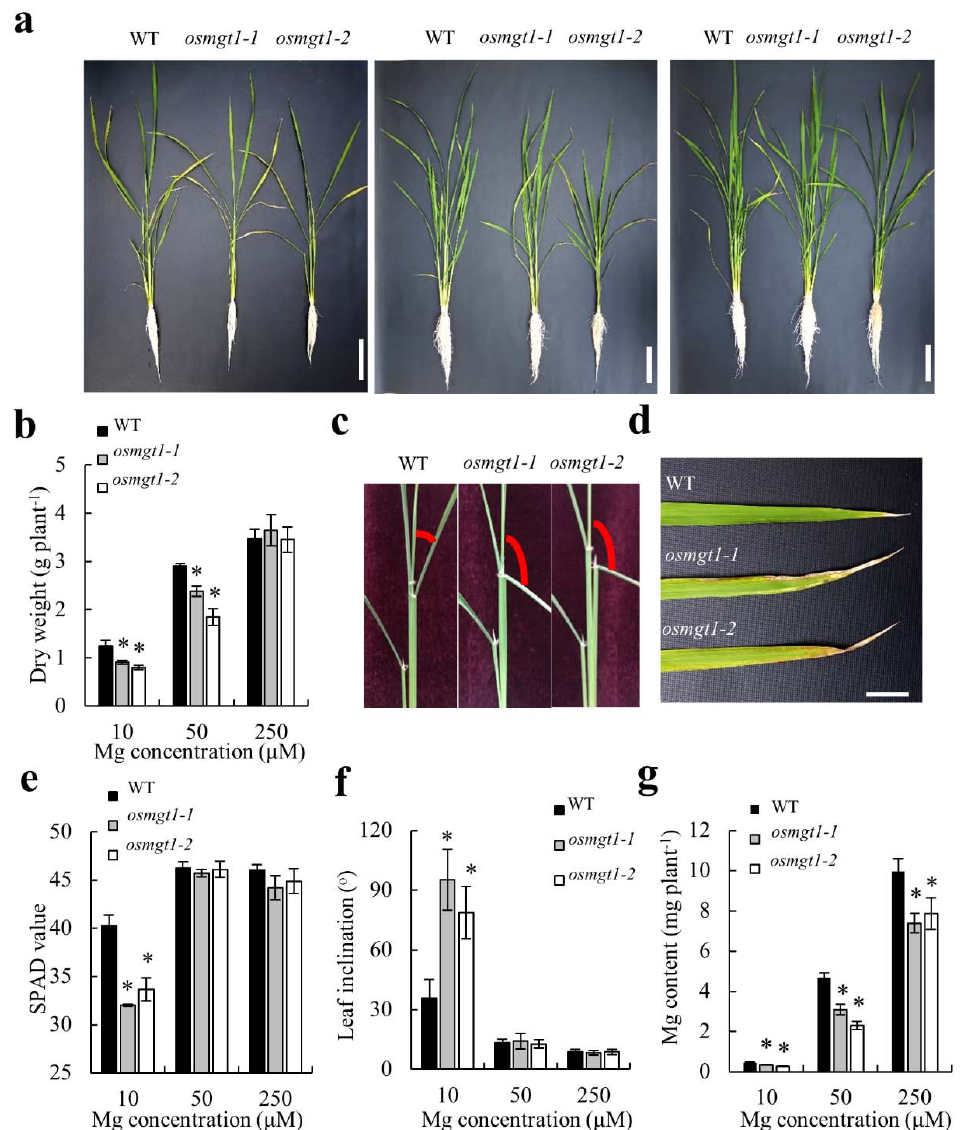
Figure 3. Sensitivity of OsMGT1 knockout lines to Mg deficiency. Seedlings of both of WT and two OsMGT1 knockout lines were grown with different Mg concentrations ( a ). Growth conditions ( a